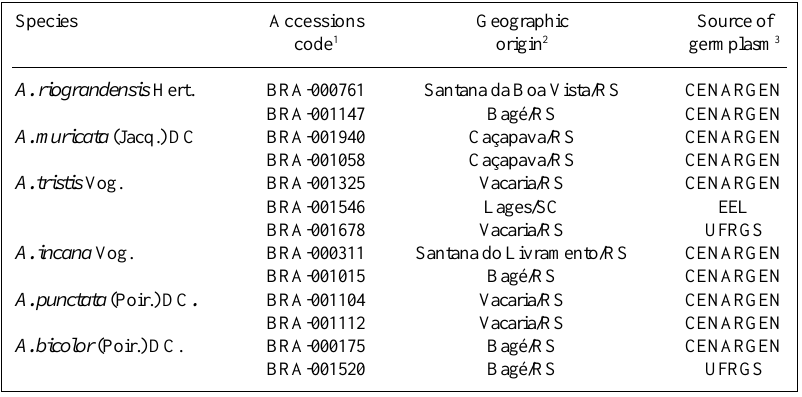
Table I - List of Adesmia accessions utilized for the determination of the mode of reproduction (Experiment 1).